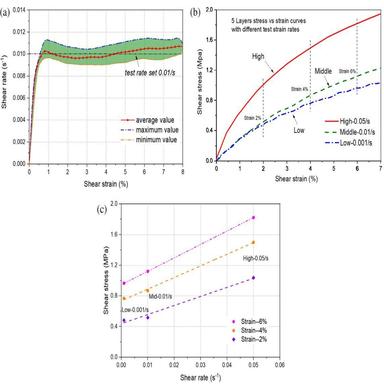
Influence of the test rates – (a) Shear rate versus test rate, (b) Effect of test rates on IM7/8552 made of 5 layers and with an 8 mm-wide localisation area and (c) Shear stress versus shear rate at given strain extracted from figure (b). (For interpretation of the references to colour in this figure legend, the reader is referred to the web version of this article.)